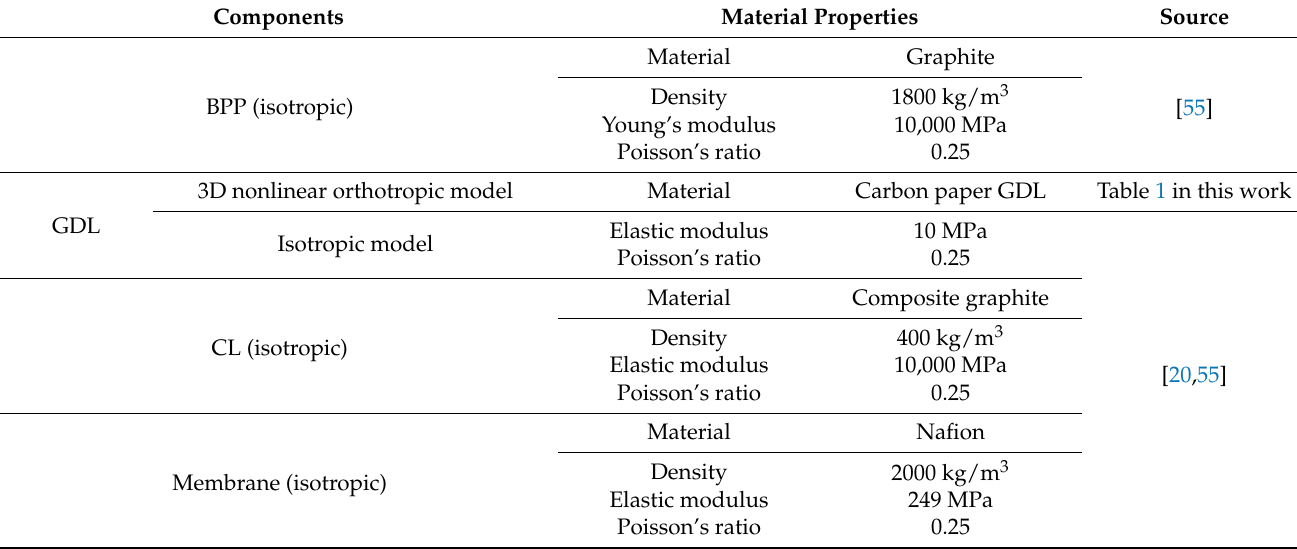
Table 3. Material specifications of the components used in a simplified PEMFC unit.